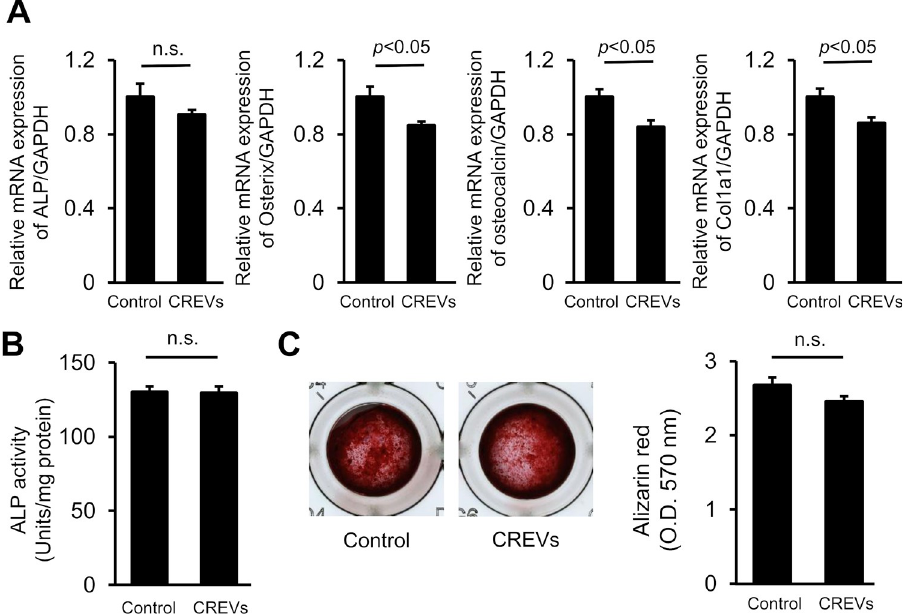
Fig 6. Effects of CREVs on the phenotypes of mouse osteoblasts. (A) The mRNA expression of osteogenic markers in mouse osteoblasts cultured with or without 200 ng/mL BMP-2 and/or 4 μ g/mL CREVs for 72 h. Results are expressed relative to Gapdh mRNA levels and are shown as the means ± SEM of 4 independent experiments. (B) The ALP activity of mouse osteoblasts cultured with or without 4 μ g/mL CREVs for 72 h. Results are expressed as the mean ± SEM of 4 independent experiments. (C) Images of Alizarin red-stained mineralized mouse osteoblasts cultured with 50 μ g/mL ascorbic acid and 10 mM β -glycerophosphate in the presence or absence of 4 μ g/mL CREVs. The absorbance of Alizarin red extracted with cetylpyridinium chloride solution (570 nm) is expressed as the mean ± SEM of 8 independent experiments. Statistical analyses were performed using the unpaired t -test.